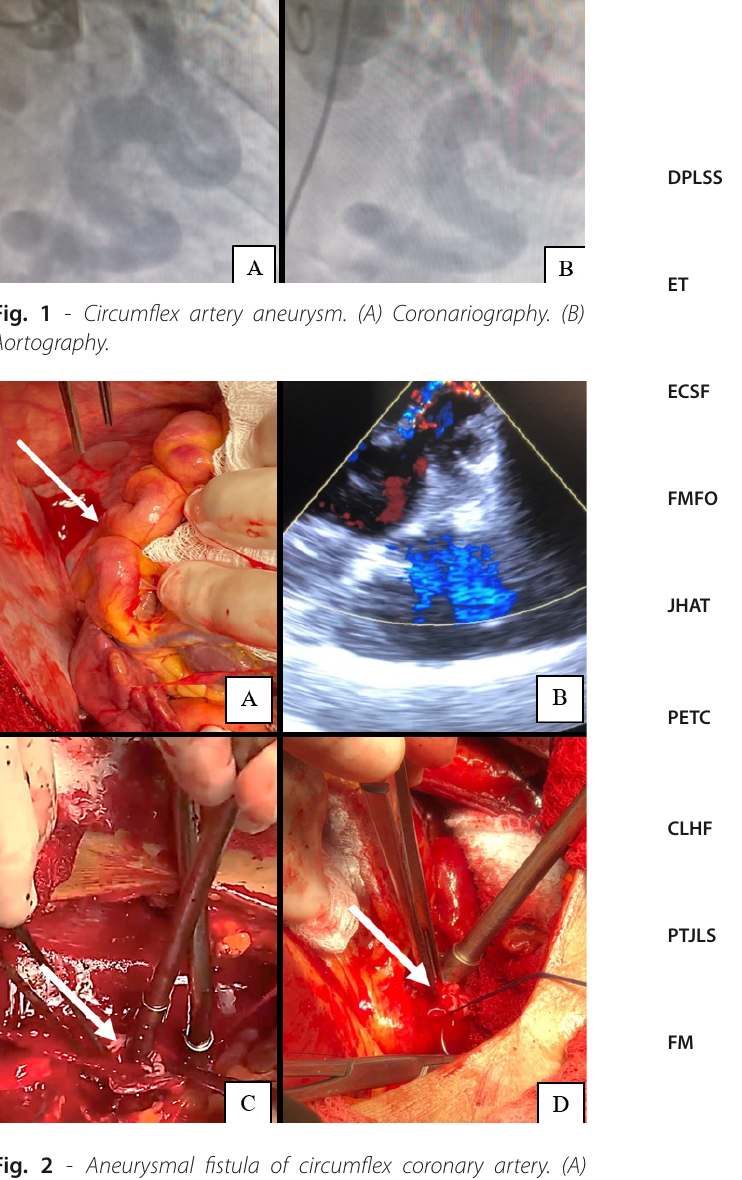
Fig. 2 - Aneurysmal fistula of circumflex coronary artery. (A) Surgical view. (B) Drainage into coronary sinus on transesophageal echocardiogram before correction. (C) Drainage site in coronary sinus fistula on surgical view. (D) Surgical